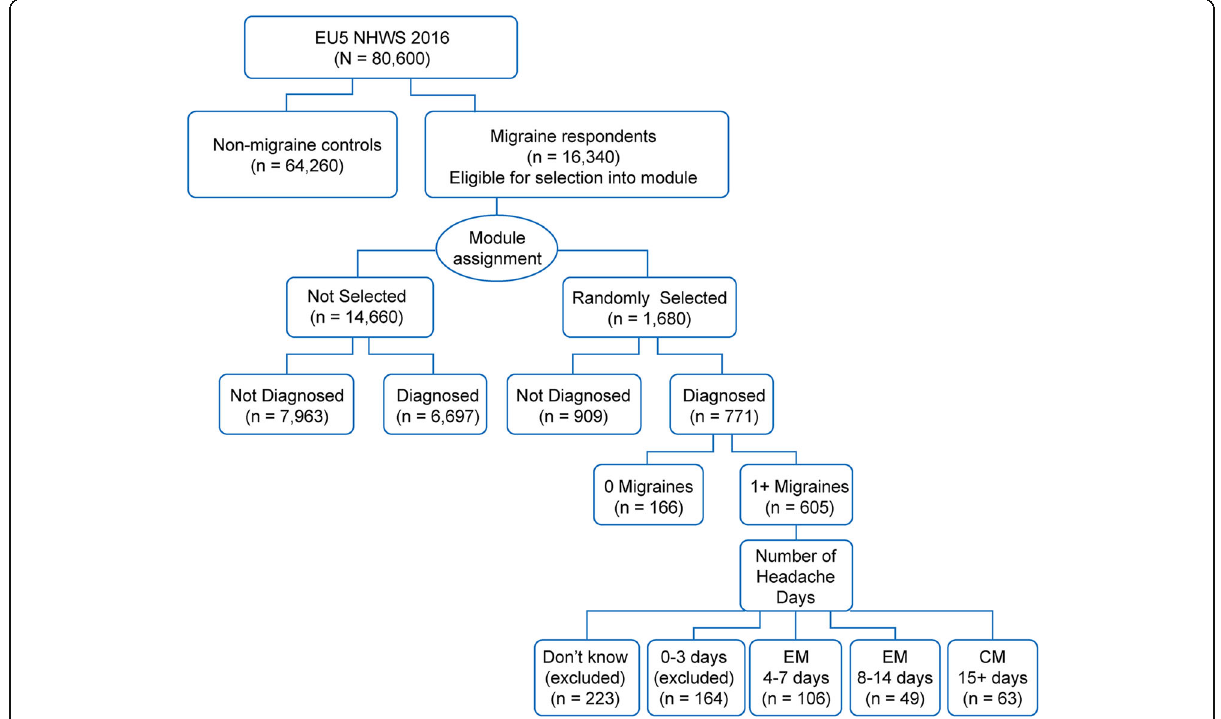
Fig. 1 Selection of study populationCM, chronic migraine; EM: episodic migraine; EU5, France, Germany, Italy, Spain, and the United Kingdom; NHWS, National Health Wellness Survey; n, the total number of respondents across the